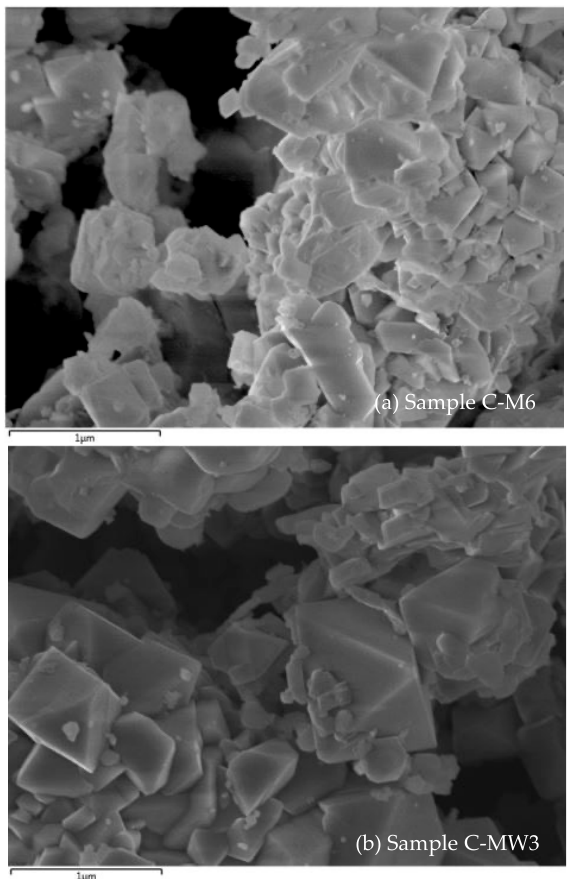
Figure 5. SEM micrograph of samples C-M6 ( a ) and C-MW3 ( b ). When calcining HTLCs, spinel phase formation occurred at much lower tempera- tures. Figure 6 shows XRD of H-M3 and H-MW1. The development of crystallization was